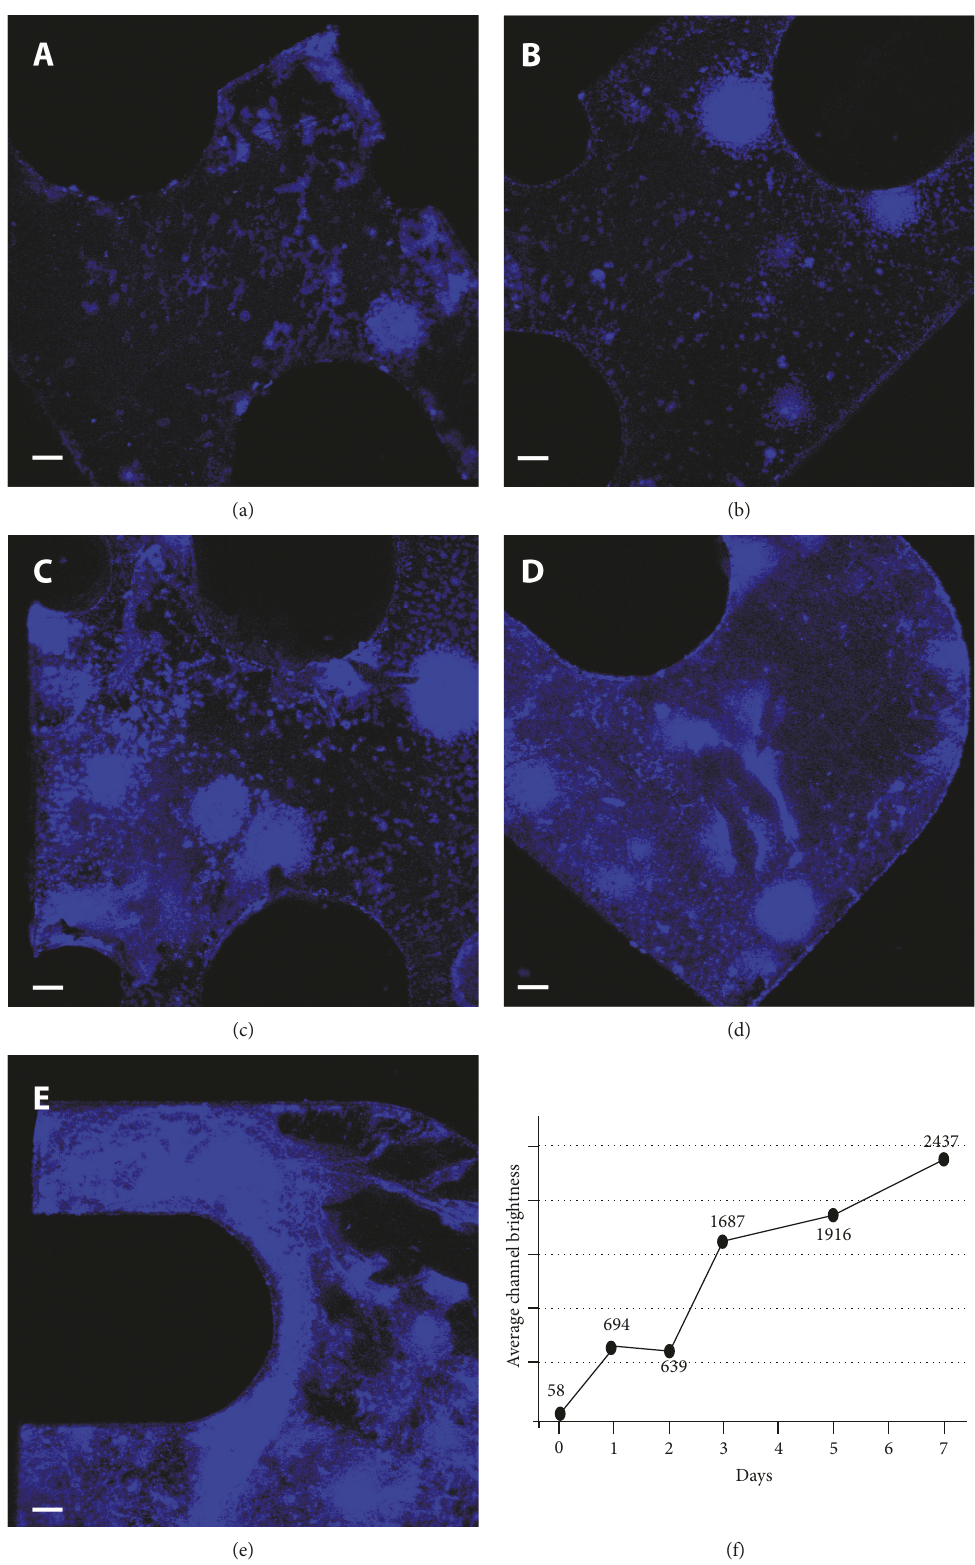
Figure 5: Time course experiments to detect the BDSCs capacity to adhere to the titanium sca ff old. The increasing blue signal (DAPI) along time course analysis shows the cells ’ adhesion and growth on titanium ((a)=after 1 day, (b) =2 days, (c)=3 days, (d) =5 days, (e) =7 days). (f) shows a graphical representation of (a) – (e) time course analysis performed by Nikon EZ-C1 viewer